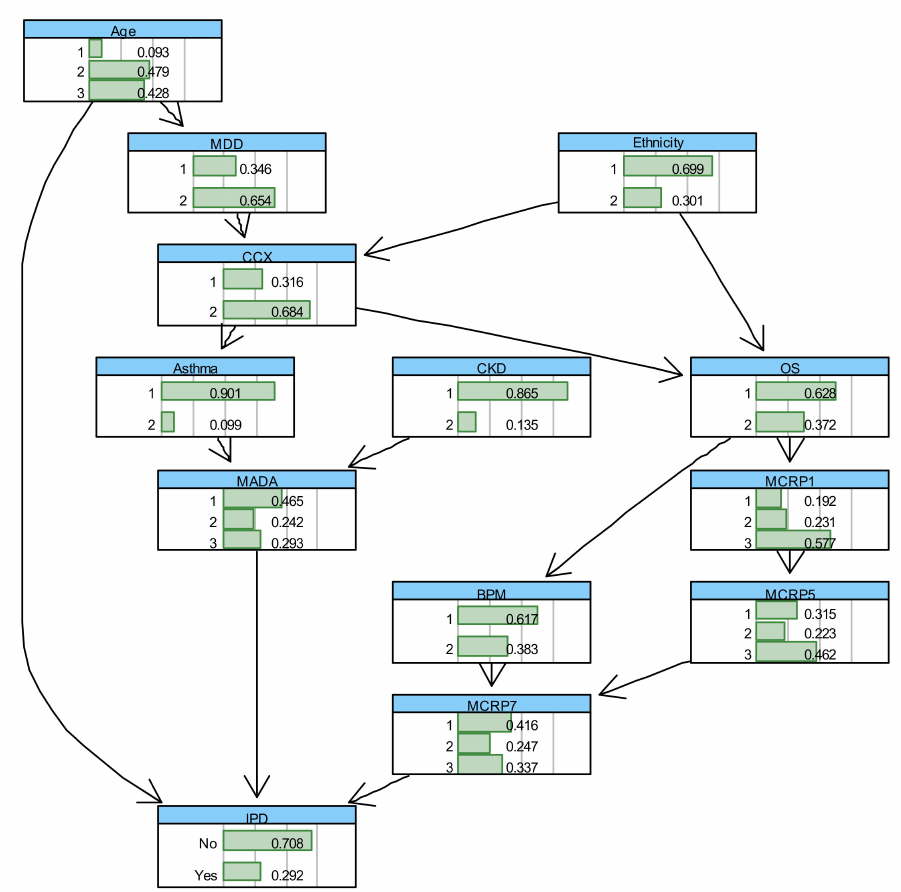
Figure 7. The BN with conditional probability tables (CPT) learned for “IPD” outcome based on the combined elicited domain expert opinions with the (balanced)